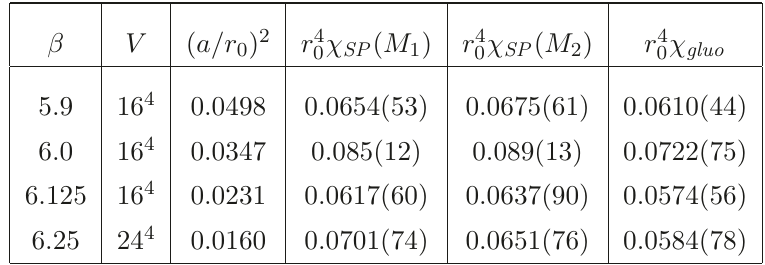
Table 1 . Determinations of χ SP and χ gluo for each β . The lattice spacings in units of the Sommer parameter r 0 were taken from ref. [42]. The values of the renormalized cut-off masses M 1 and M 2 correspond, respectively, to r 4 h ν i /V = 1 · 10 − 3 and 3 · 10 − 3 . Assuming eq. (2.32) and the values of 0 r 0 and Σ R measured respectively in [43] and [44], their values in physical units are M 1 ≃ 33 MeV and M 2 ≃ 98 MeV.